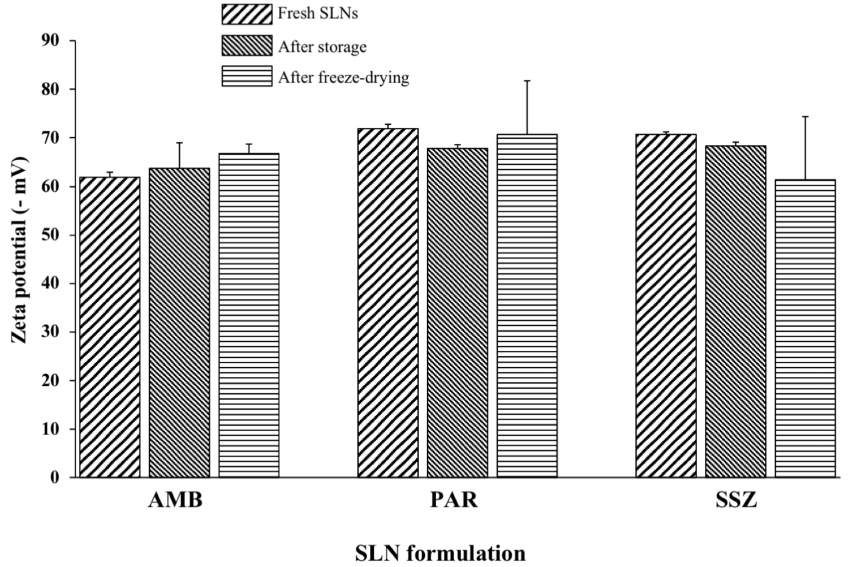
Figure 5. ZPs (zeta potentials) of freshly prepared, stored (24 months), and lyophilized AMB-SLNs, PAR-SLNs, and SSZ-SLNs ( n =